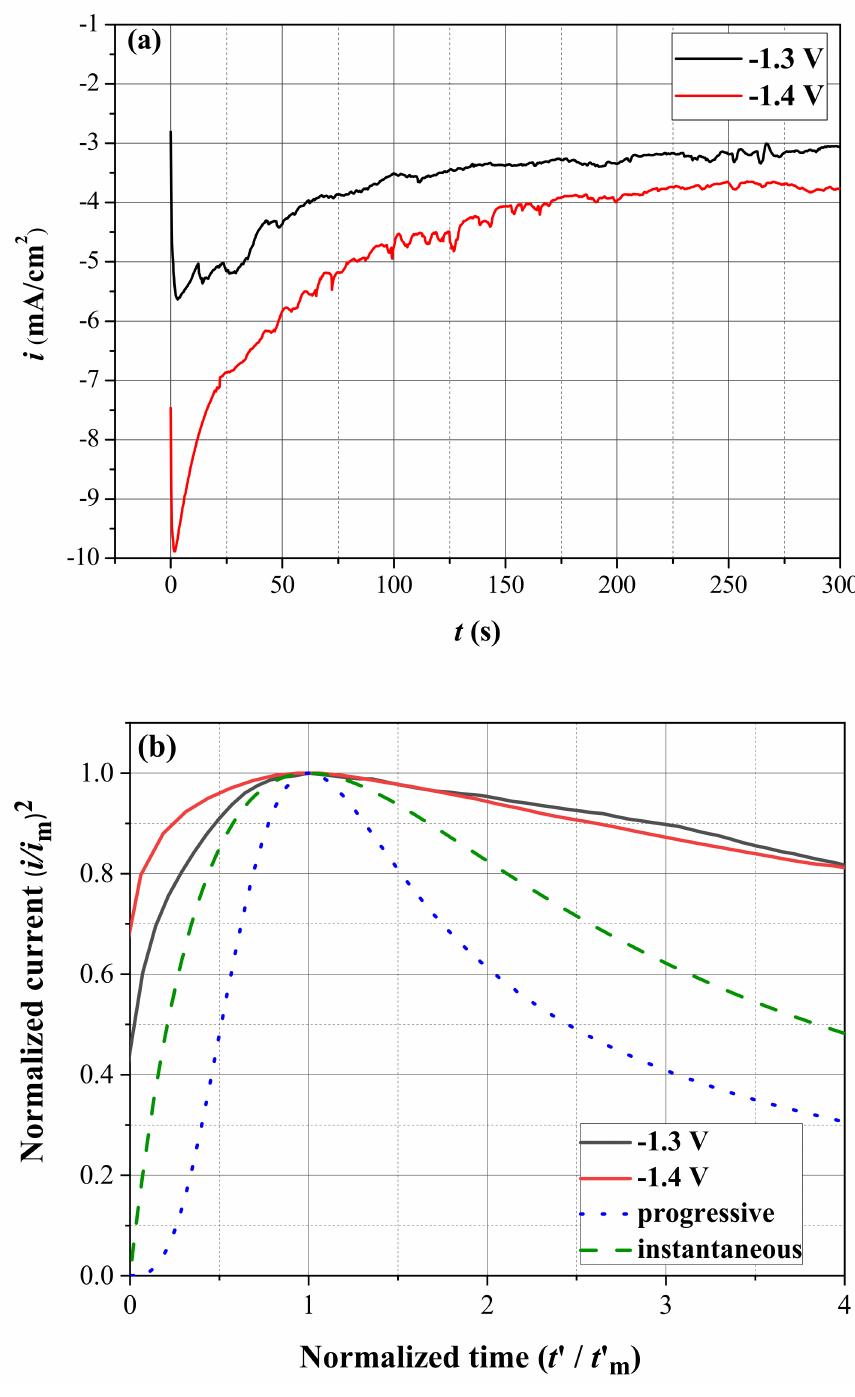
Figure 4. ( a ) Chronoamperometry current vs. time transients for deposition potentials of − 1.3 and − 1.4 V. Sampling rate: 5 Hz. ( b ) Normalized experimental curves (solid lines) compared to those predicted by Scharifker’s models for instantaneous nucleation (Equation (1), dashed green line) and progressive nucleation (Equation (2), dotted blue